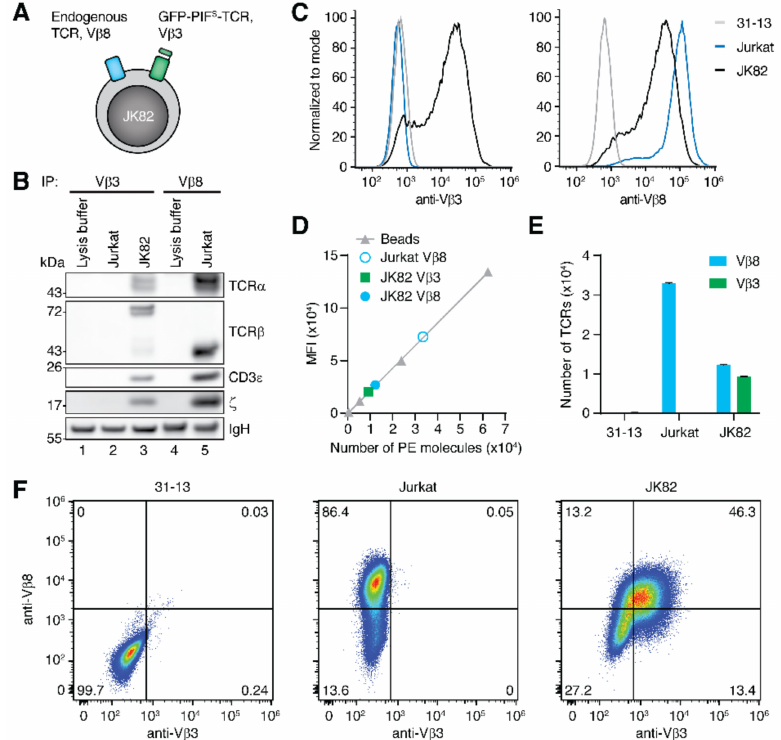
Figure 1. Analysis of the number of V β 3 and V β 8 TCRs on the cell surface. ( A ) Scheme of the JK82 cells expressing the endogenous V β 8 TCR and the transduced GFP-PIF S -TCR containing a V β 3 TCR β chain. ( B ) Lysis buffer, Jurkat or JK82 cell lysates were used to immuno-precipitate TCRs with either anti-V β 3 or anti-V β 8 antibodies. Purified proteins were separated by SDS–PAGE and the Western blot developed for the TCR subunits TCR α , TCR β , CD3 ε , and ζ . ( C ) JK82, Jurkat, and 31–13 cells were stained with saturating amounts of anti-V β 3 or V β 8 antibodies labeled with PE and analyzed by flow cytometry. ( D ) Quantibrite beads coupled to defined amounts of PE molecules were measured in a flow cytometer to generate a linear relation of numbers of PE molecules versus PE fluorescence (given as mean fluorescence intensity, MFI). The values of the MFI measurement in ( C ) only considering the PE-positive cells as well as the calculated number of PE molecules is shown as well. ( E ) The graph shows the calculated total number of TCRs on the cell surface per cell of 31–13, Jurkat, and JK82 cell lines. Error bars represent the SEM ( n = 4 − 5). ( F ) 31–13, Jurkat and JK82 cells were co-stained with anti-V β 3 (eFluor405) and anti-V β 8 (PE) antibodies and analyzed by flow cytometry. One representative experiment of n = 3 is